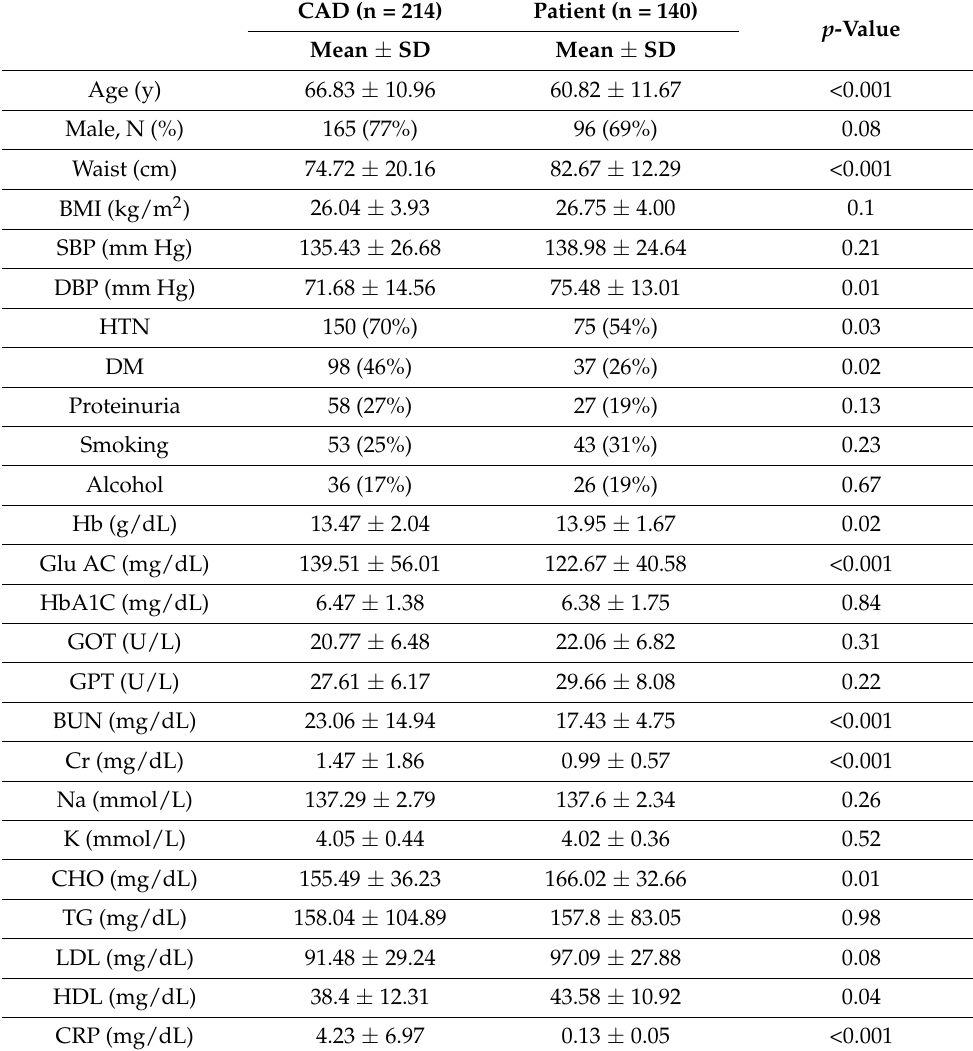
Table 1. Clinical baseline characteristics of the total